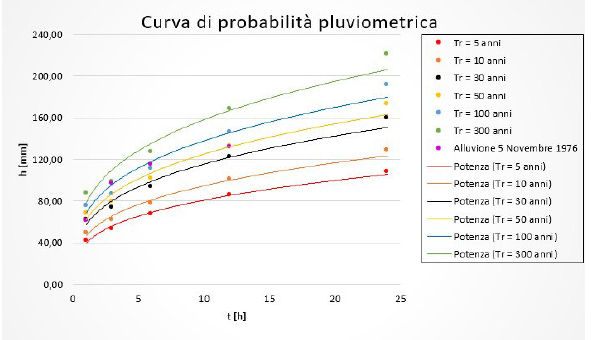
Figure 11 . Pluviometric probability curves referring to return periods of 5, 10, 30, 50, 100 and 300 years. Table 1 . Rainfall height calculated from the pluviometric probability curves for the considered return time and basin concentration time and peak flow rate according to the rational or Turazza method.